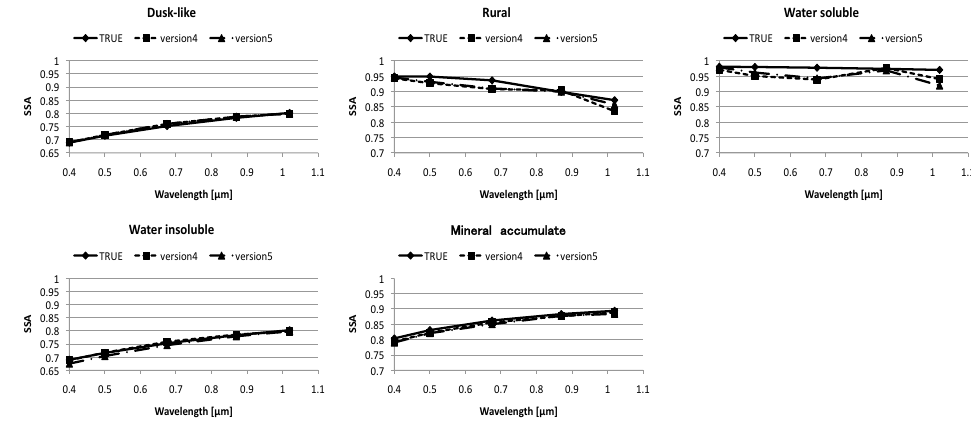
Fig. 5. SSA values derived by SKYRAD.pack version 4 and version 5 algorithms for the dust-like and rural aerosol types of WCP (Deepak and Gerber, 1983) and for the water soluble, water insoluble, and mineral accumulate aerosol types of Hess et al. (1998).